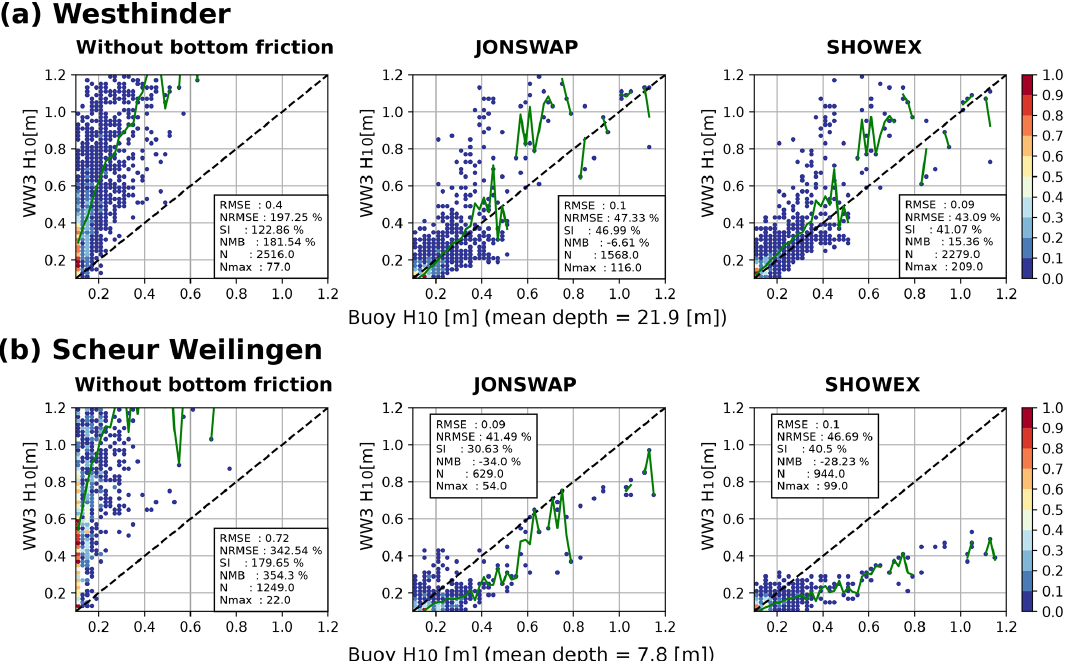
Figure 16. WW3-Buoy H 10 comparison for tests without bottom friction, using default JONSWAP and with SHOWEX parameterization including the implemented bottom sediment map. Results for (a) Westhinder and (b) Scheur Wielingen buoy location for the year 2014. Green line shows the modeled averaged values at each 0.02m wave height bin. Color bars represent the wave height occurrences normalized by the total number of analyzed data N